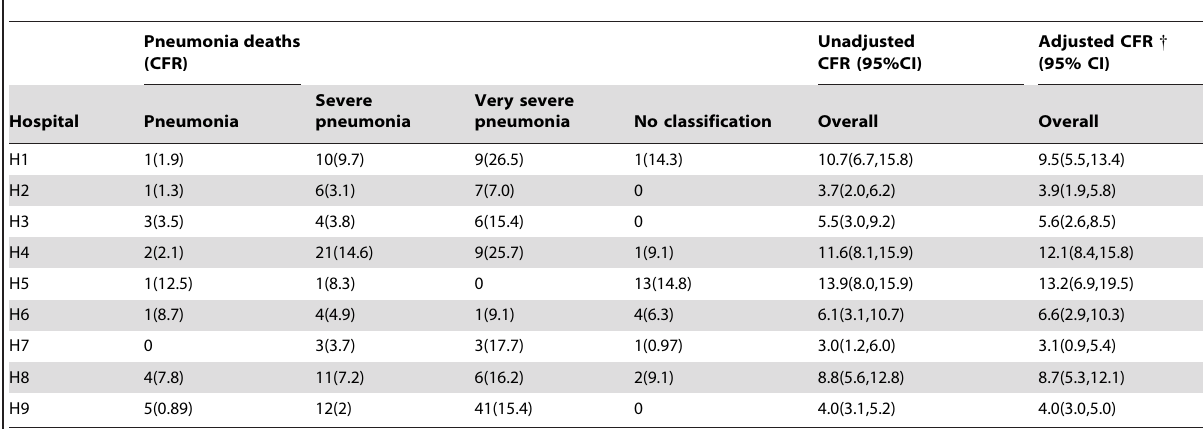
Table 2. Outcome for paediatric admissions with pneumonia in 9 Kenyan district hospitals.